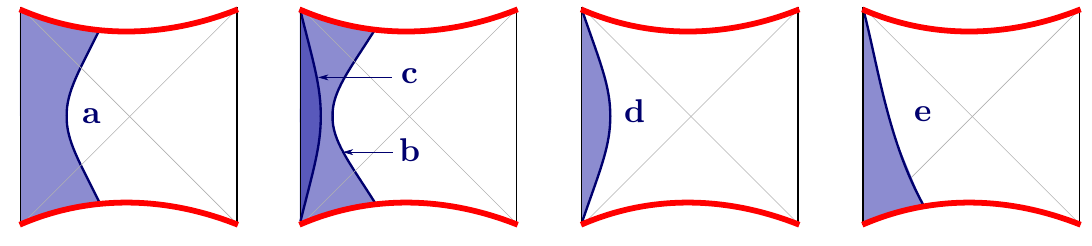
Figure 31 . Lorentzian ETW branes for various values of T